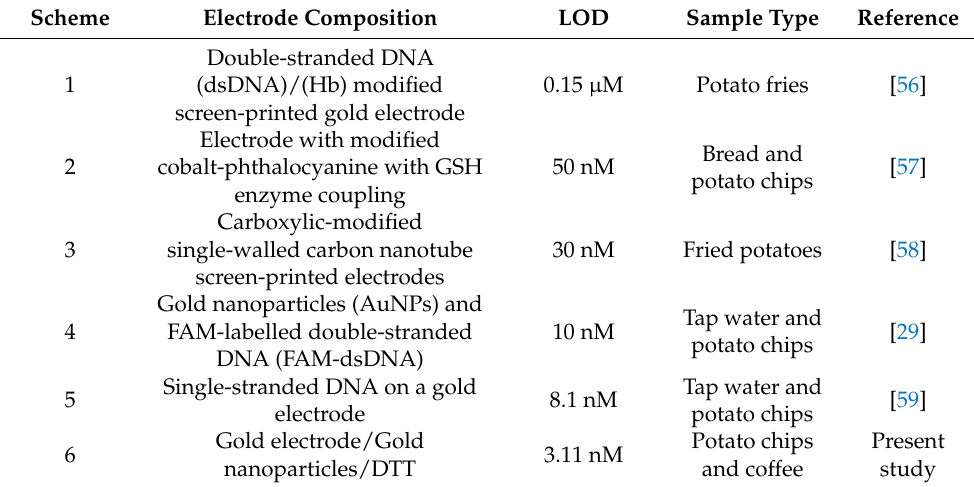
Table 1. A Comparison of Different Electrode Systems for Detection of ACR.